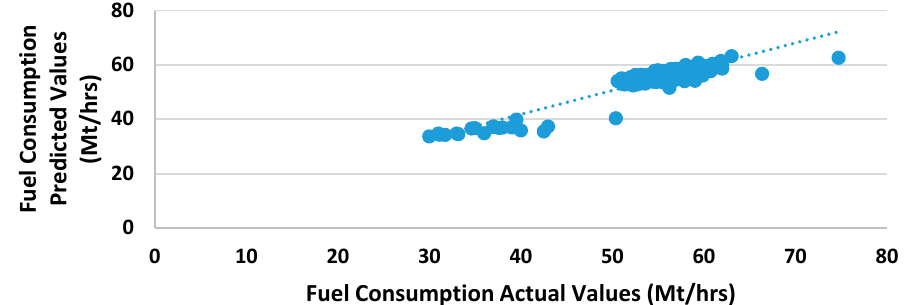
Figure 9. Scatter plot of actual values and predicted values.